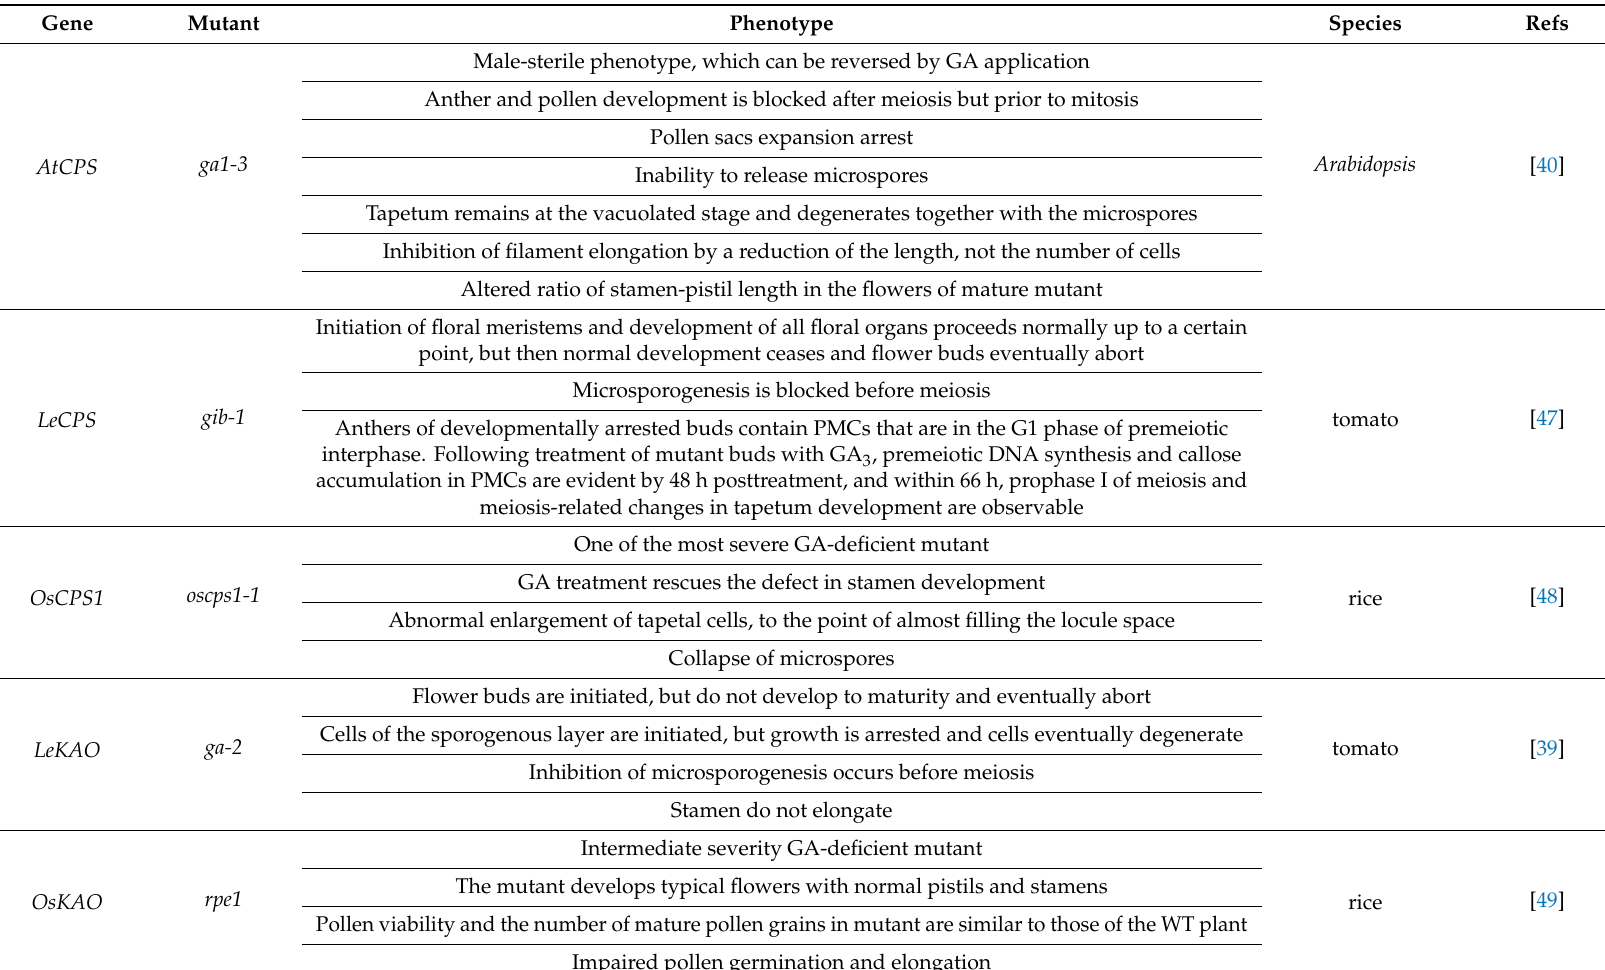
Table 1. Stamen-related features of GA deficient mutants. ent -copalyl diphosphate synthase (CPS); ent -kaurene acid oxidase (KAO); GA 20-oxidase (GA20ox); GA 3-oxidase (GA3ox); reduced pollen elongation1 ( rpe1 ); pollen mother cells